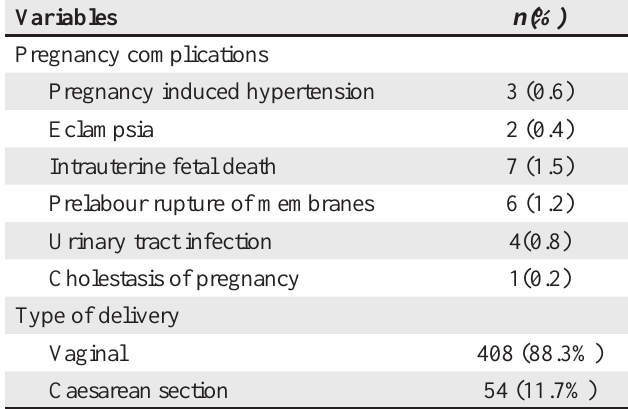
Table 3 : Pregnancy complications and maternal and fetal outcome among adolescent pregnancies